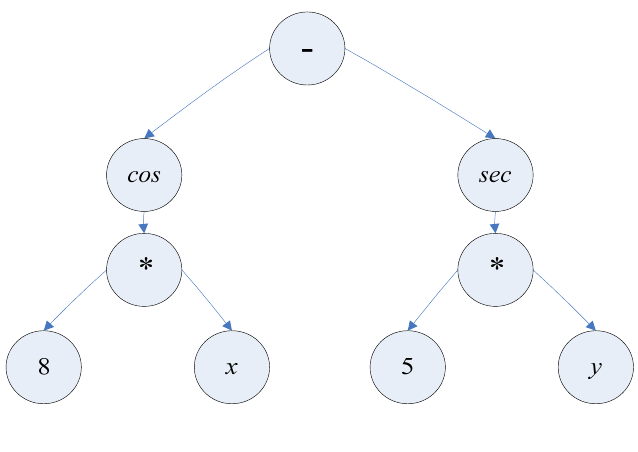
Figure 2. Example of GP parse tree